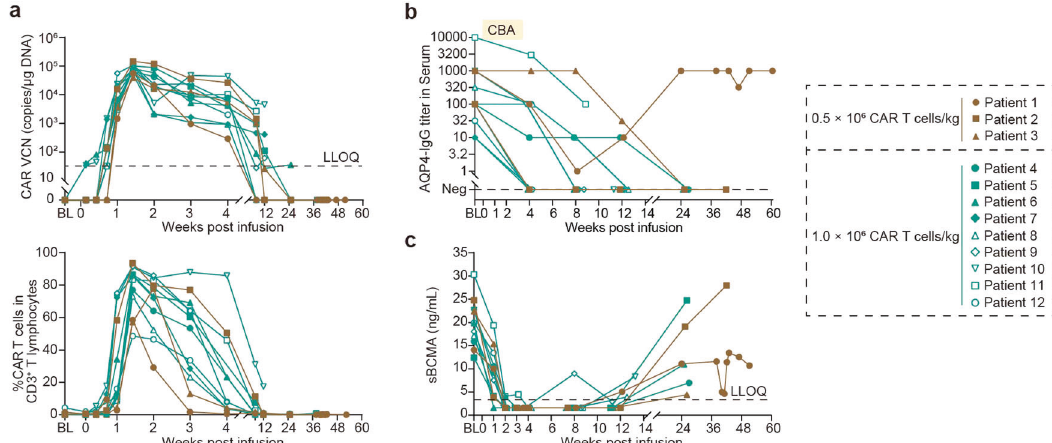
Fig. 3 CT103A expansion and persistence, kinetic changes of serum AQP4-IgG and BCMA post-infusion. a Kinetic changes of CAR transgene detected by ddPCR and CAR T-cell percentage in CD3 + T lymphocytes detected by fl owcytometry post infusion. LLOQ denotes lower limit of quanti fi cation (32 copies/ μ g DNA). b , c Kinetic changes of serum AQP4-IgG detected by cell-based assay (CBA) and BCMA post-infusion. LLOQ denotes lower limit of quanti fi cation (3.2 ng/mL). Levels of sBCMA lower than LLOQ were shown as 1/2